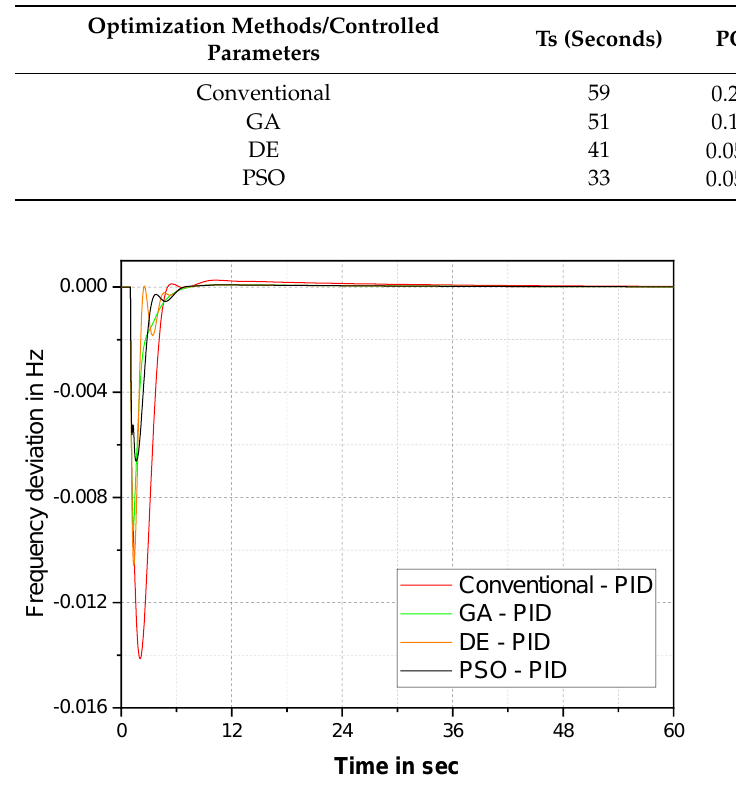
Figure 10. delF comparison for the ITAE cost function.